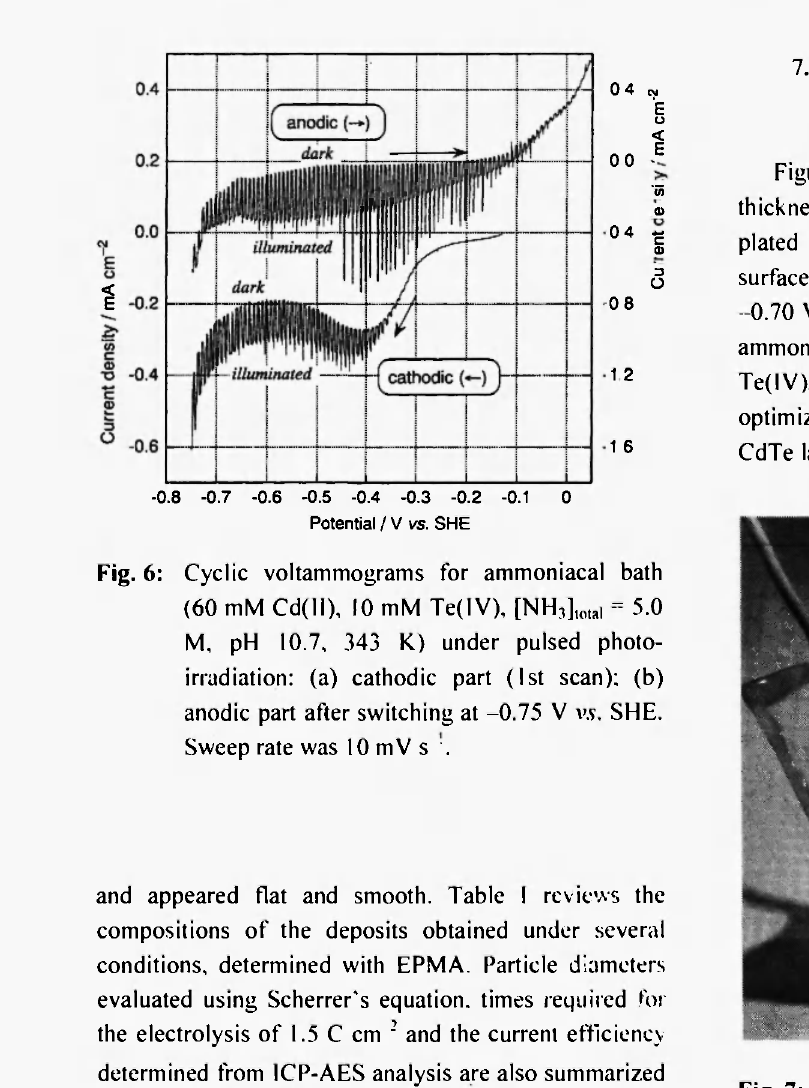
Fig. 7: Photograph of CdTe layer with thickness of 10 μιη electrodeposited on polished Au-plated Cu substrate. Electrodeposition was performed under illumination from ammoniacal bath (40 mM Cd(ll), 10 mM Te(lV), [NH 3 ] lota , = 5.0